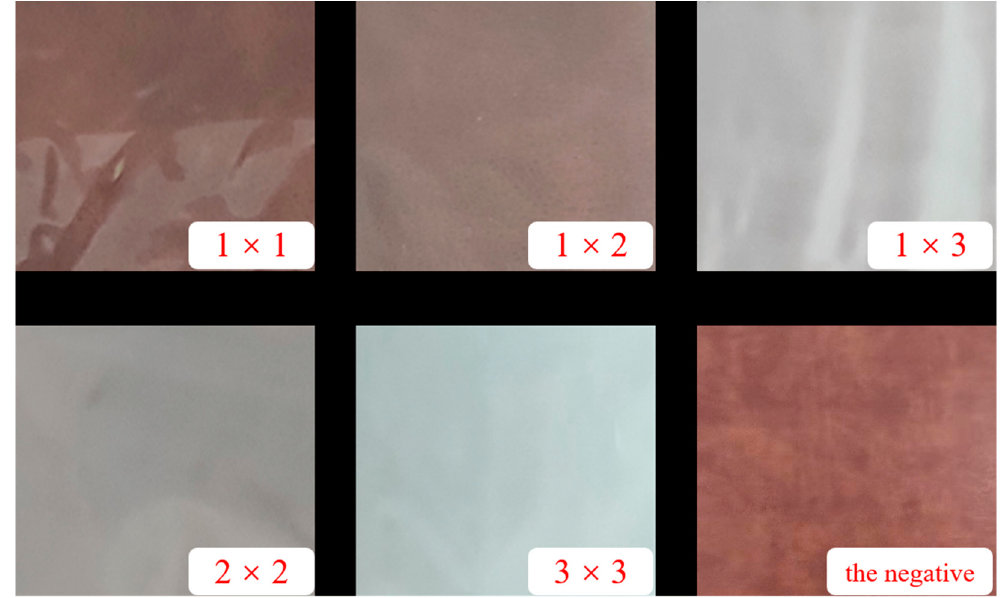
Figure 10. The surface pictures of PA510/SiO 2 films with different stretching ratios; the last picture is the negative.